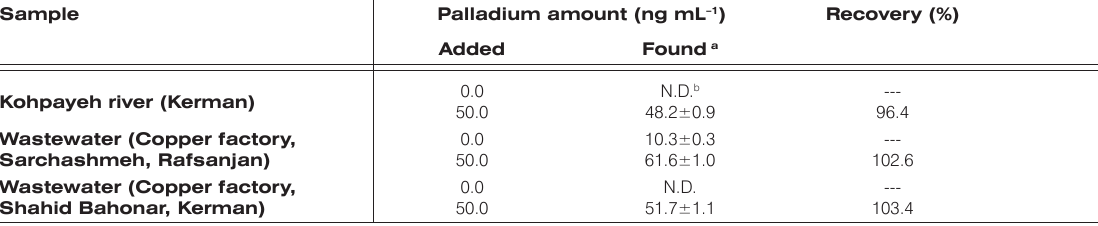
Table 4. Determination of palladium in water samples.